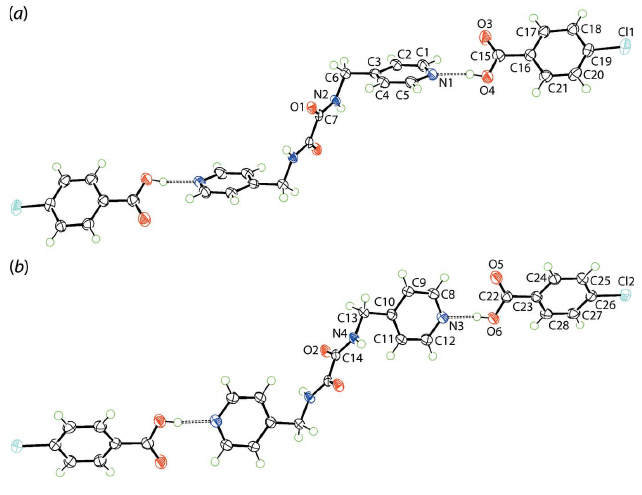
Figure 1 The molecular structures of the two centrosymmetric three-molecule aggregates in the crystal of (I) showing the atom-labelling scheme and displacement ellipsoids at the 70% probability level. In ( a ), the unlabelled atoms are related by the symmetry operation (i) 1 (cid:4) x , 2 (cid:4) y , (cid:4) z and in ( b ), by (ii) 2 (cid:4) x , 2 (cid:4) y , (cid:4) z